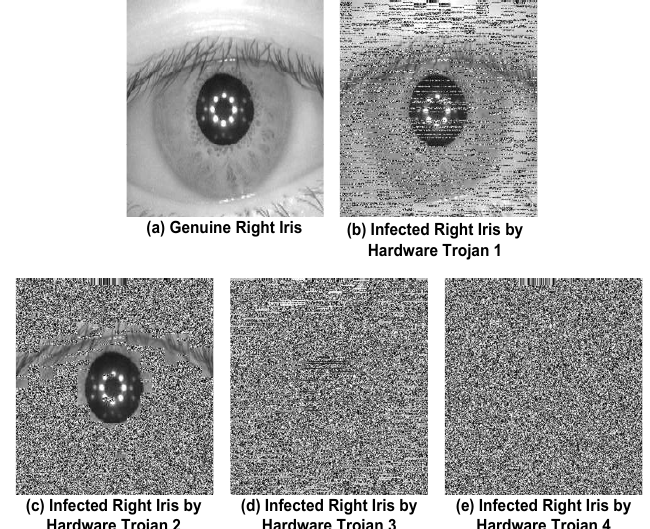
Figure 8. Attack Iris Example (1): The payloads of the Hardware Trojans in sabotaging the image prints of the left iris.